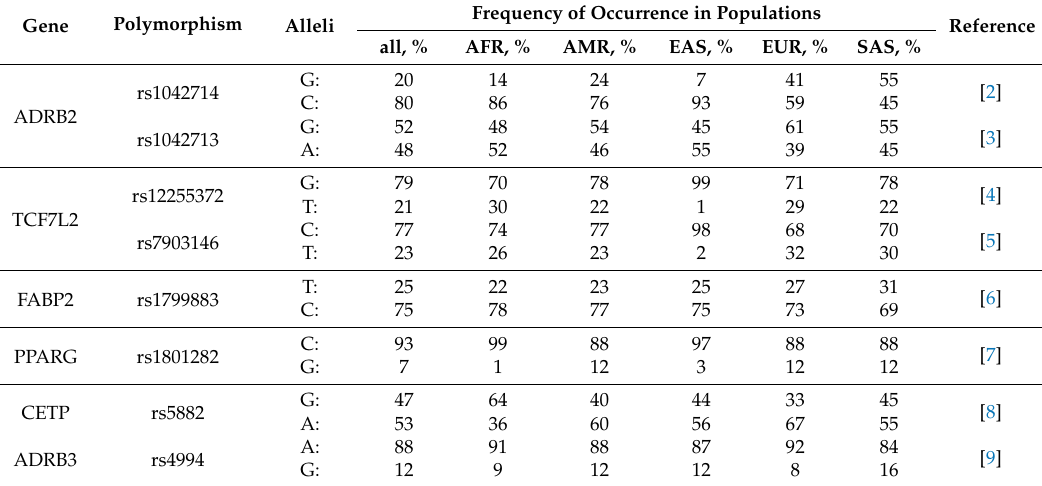
Table 1. Population genetics for genes responsible for absorption of carbohydrates and